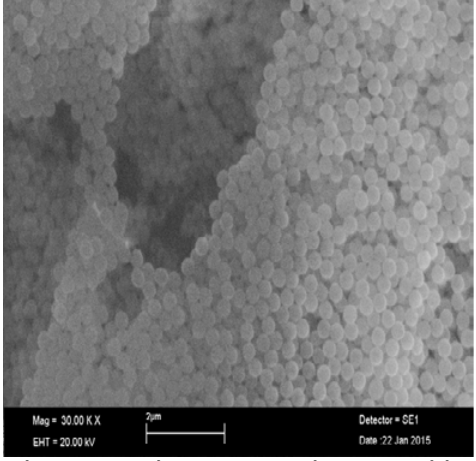
Fig.3: SEM image of vertical deposition via evaporation.